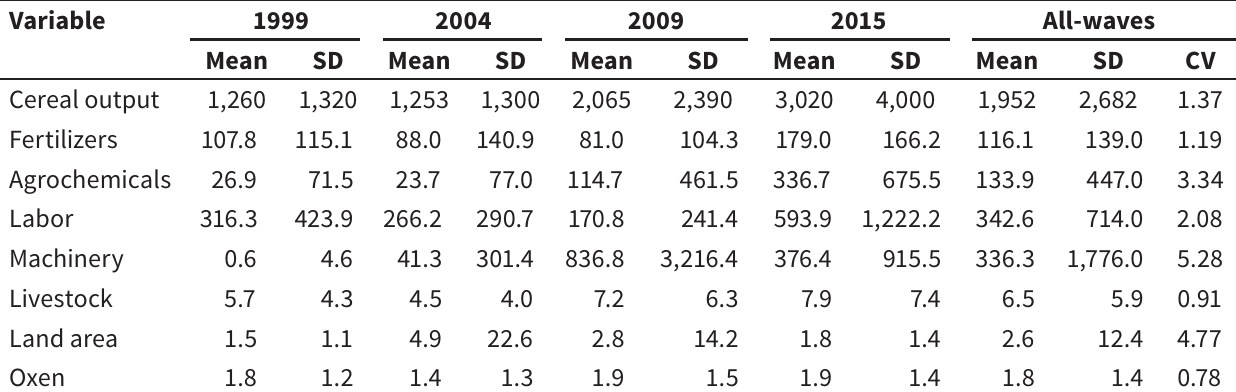
Summary statistics of the data (NT = 1,648